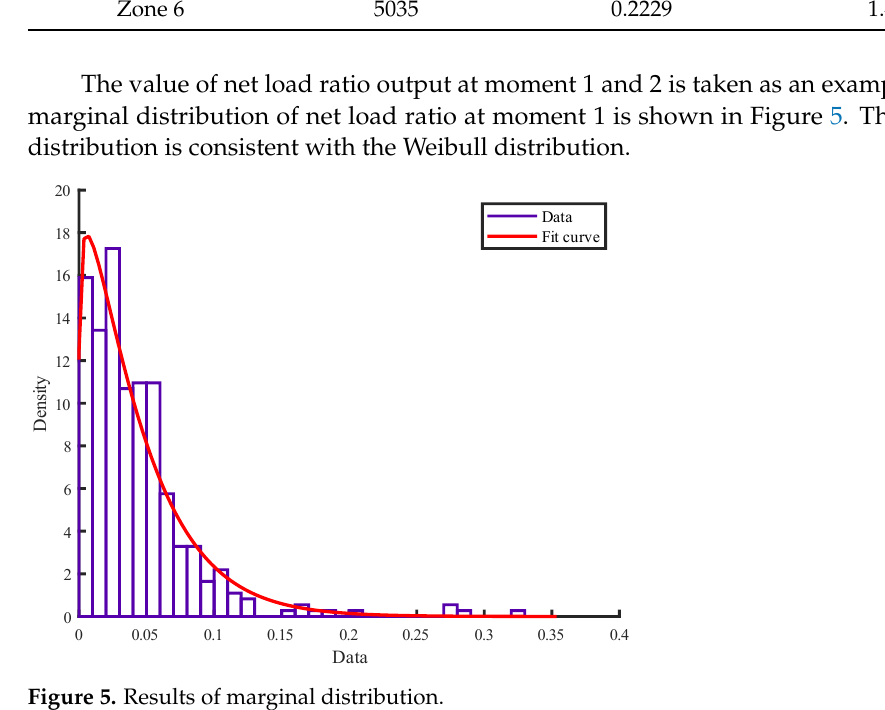
Figure 5. Results of marginal distribution.